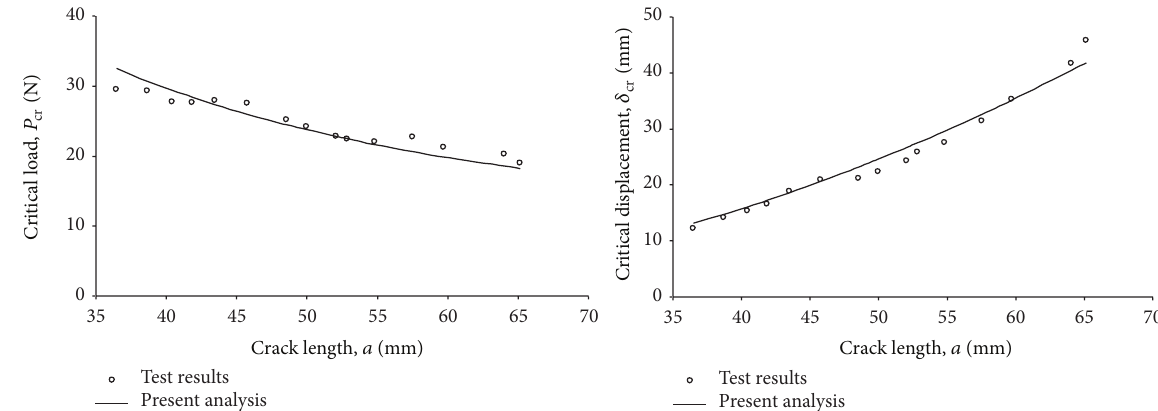
) and the corresponding displacement (𝛿 ) cr cr